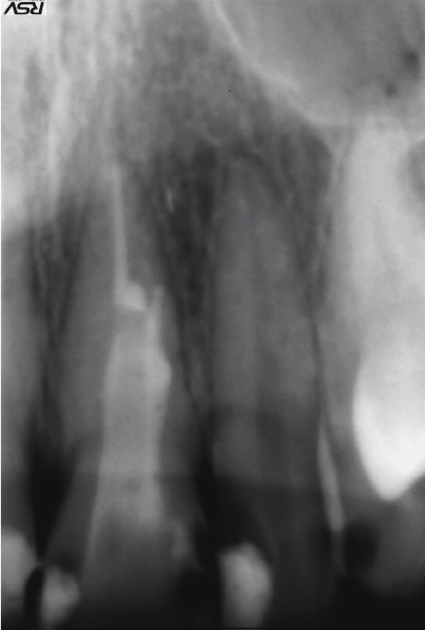
Figure 8: Postoperative